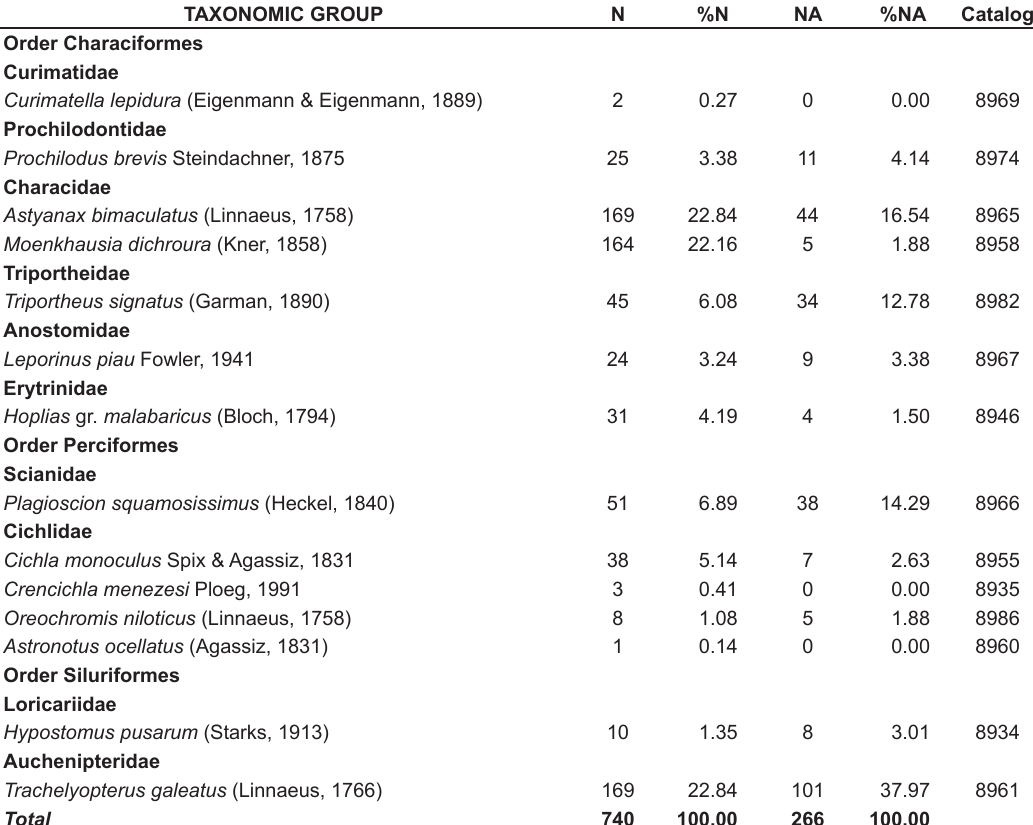
Table 3. Taxonomic group, number of sampled individuals (N), the percentage of sampled individuals (%N), number of samples analyzed individuals (NA), the percentage of analyzed individuals (%NA), of the fish species caught in Umari reservoir, Rio Grande do Norte, Brazil, in the year of